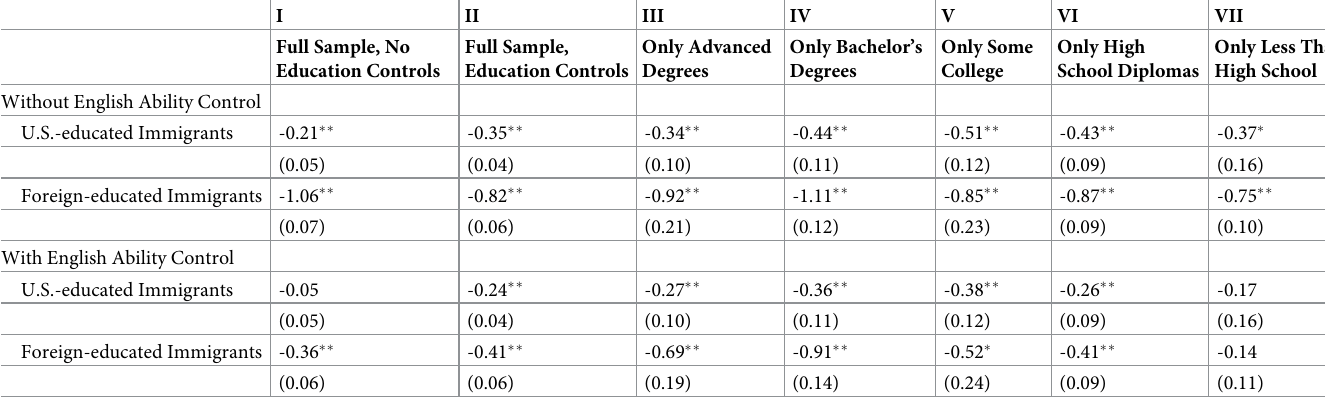
Table 3. Immigrant-native differences in PIAAC literacy